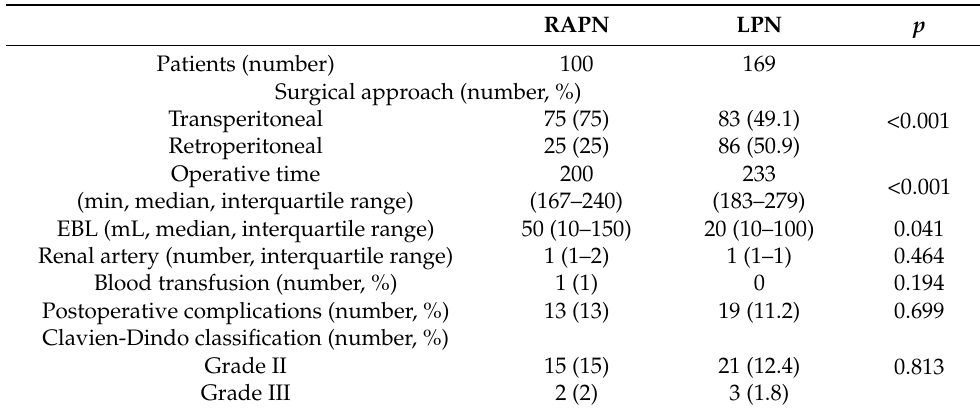
Table 2. Surgical outcomes.